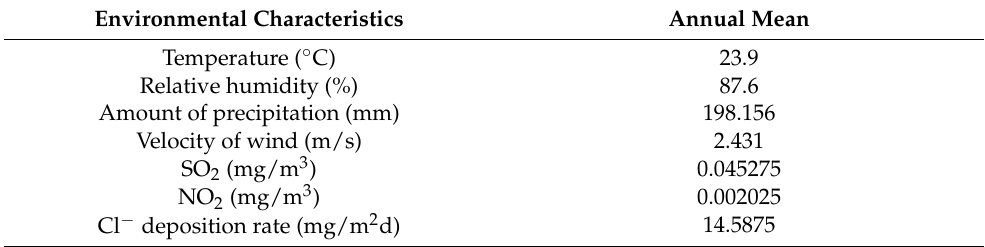
Figure 2. Location of the coastal atmospheric exposure testing station and the indoor exposure testing shed: ( a ) location of Wanning Natural Environment Test Station; ( b ) ventilated rooms for atmospheric exposure tests. Table 2. Atmospheric environmental data for the Wanning Environmental Test Station in 1997.